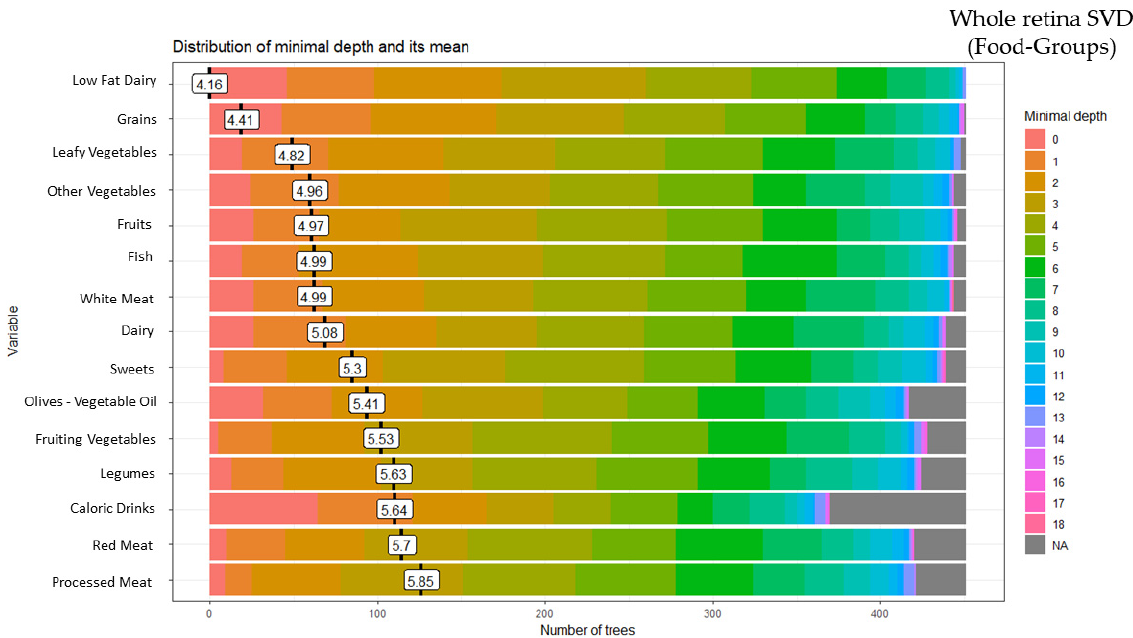
Figure 3. Random forest food group and whole retina superficial vessel density (SVD).